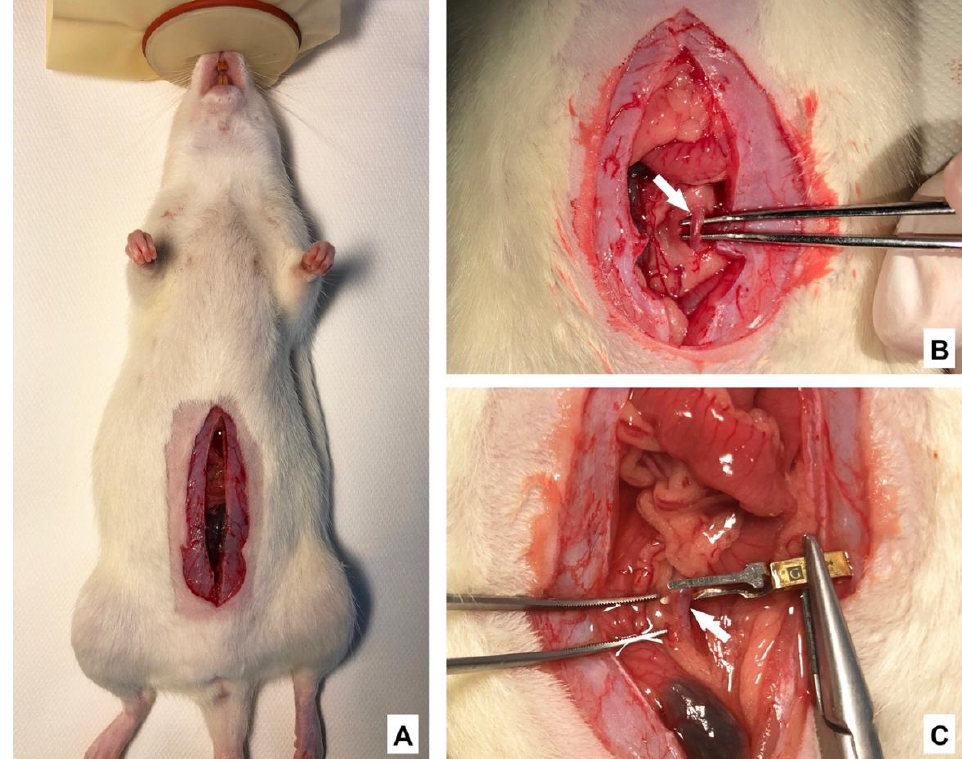
Figure 6. Surgical procedure. ( A ): laparotomy. ( B ): mobilization of the abdominal aorta (white arrow) about 0.5 cm above the bifurcation. ( C ): micro-bulldog clamp to be placed on the aorta (white arrow).